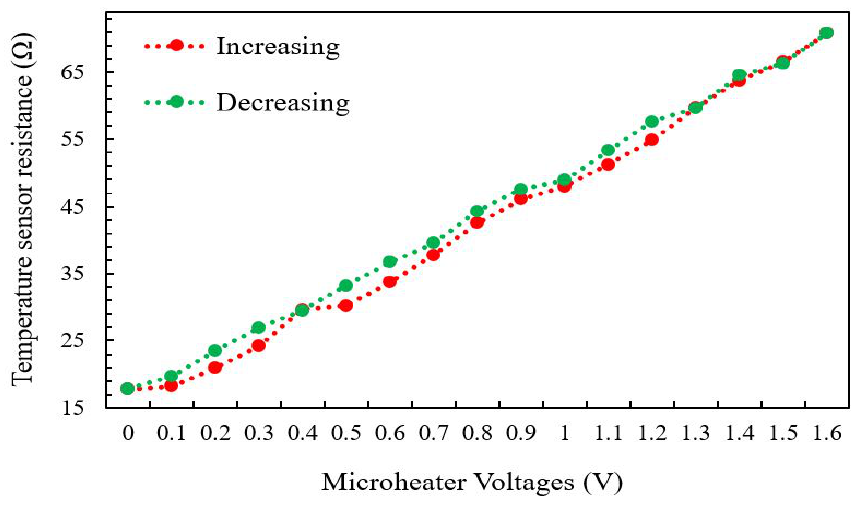
Figure 20. Temperature sensor resistance vs. increasing and decreasing of the micro-heater voltage.